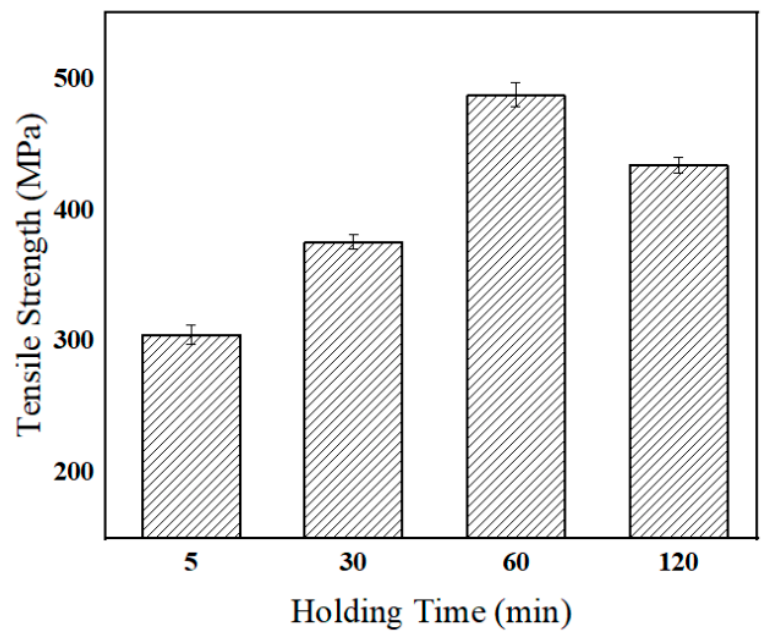
Figure 8. Tensile strength of TLP joints, with holding time 5; 30; 60 and 120 min.